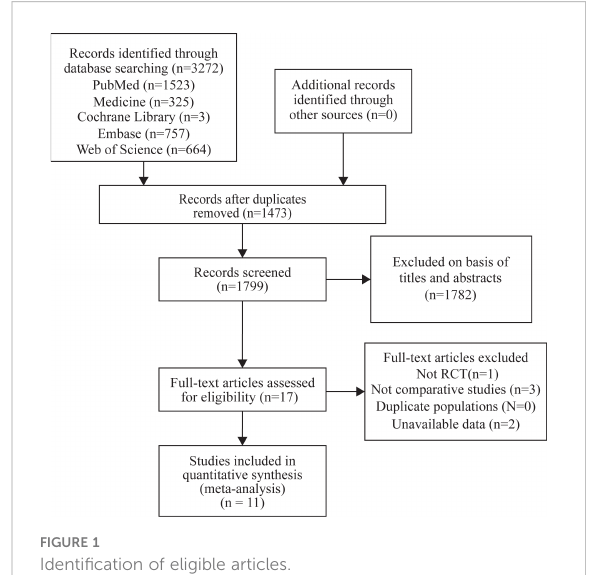
FIGURE 1 Identi fi cation of eligible